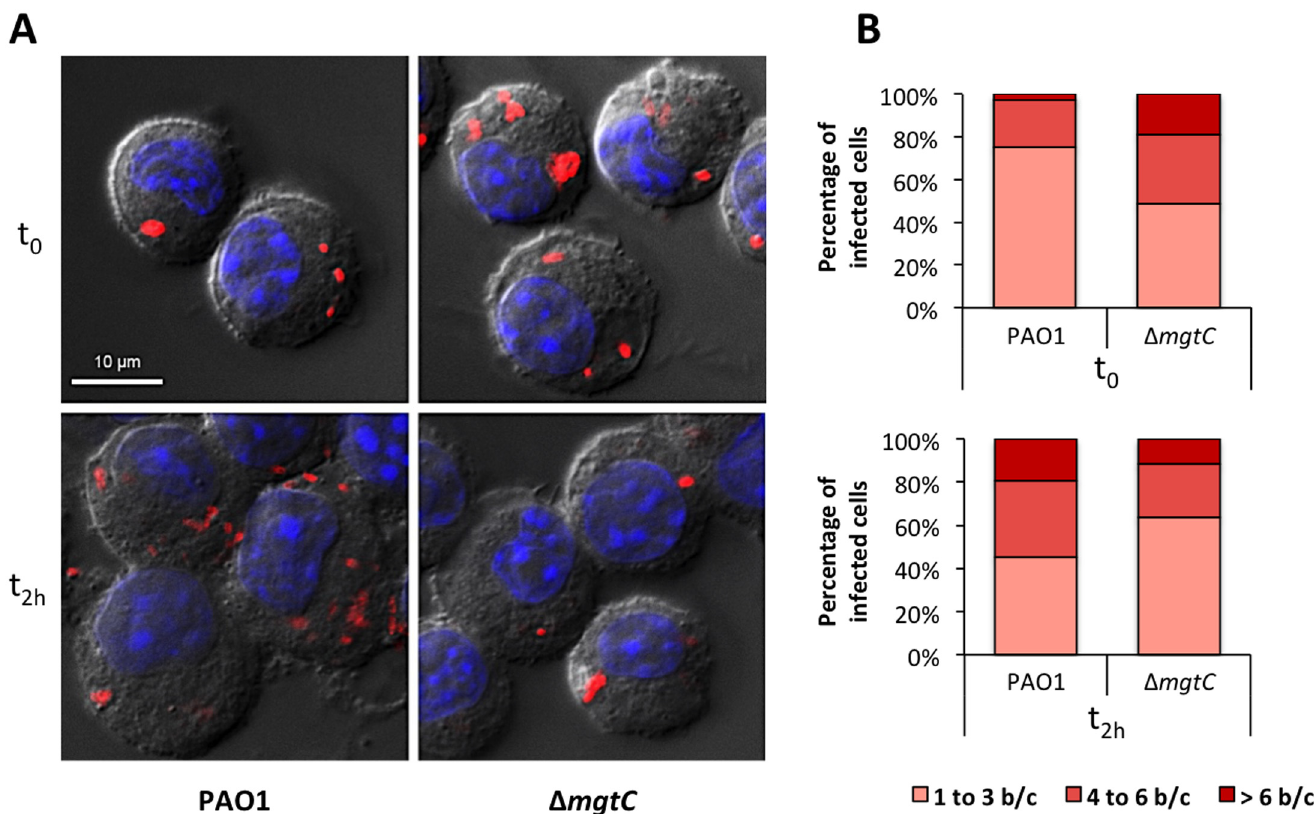
Fig 4. Visualisation and quantification of intracellular bacteria in fixed macrophages. Macrophages infected with PAO1 or Δ mgtC mutant expressing mCherry were fixed after phagocytosis and 20 min (t 0 ) or 2 hours (t 2h ) treatment with amikacin. (A) Visualization of intracellular bacteria. The images shown were obtained by making a maximum projection of 12 central planes from a Z-stack. The merged image shows Differential Interference Contrast (DIC), nucleus staining (blue) and bacteria expressing mCherry (red). (B) Count of the number of bacteria in infected macrophages from images obtained with the maximum projection. The numbers of bacteria per cell (b/c) were classified in three groups and percentage of each class is shown. Count is done from at least 20 cells and results are expressed as means from three independent experiments.